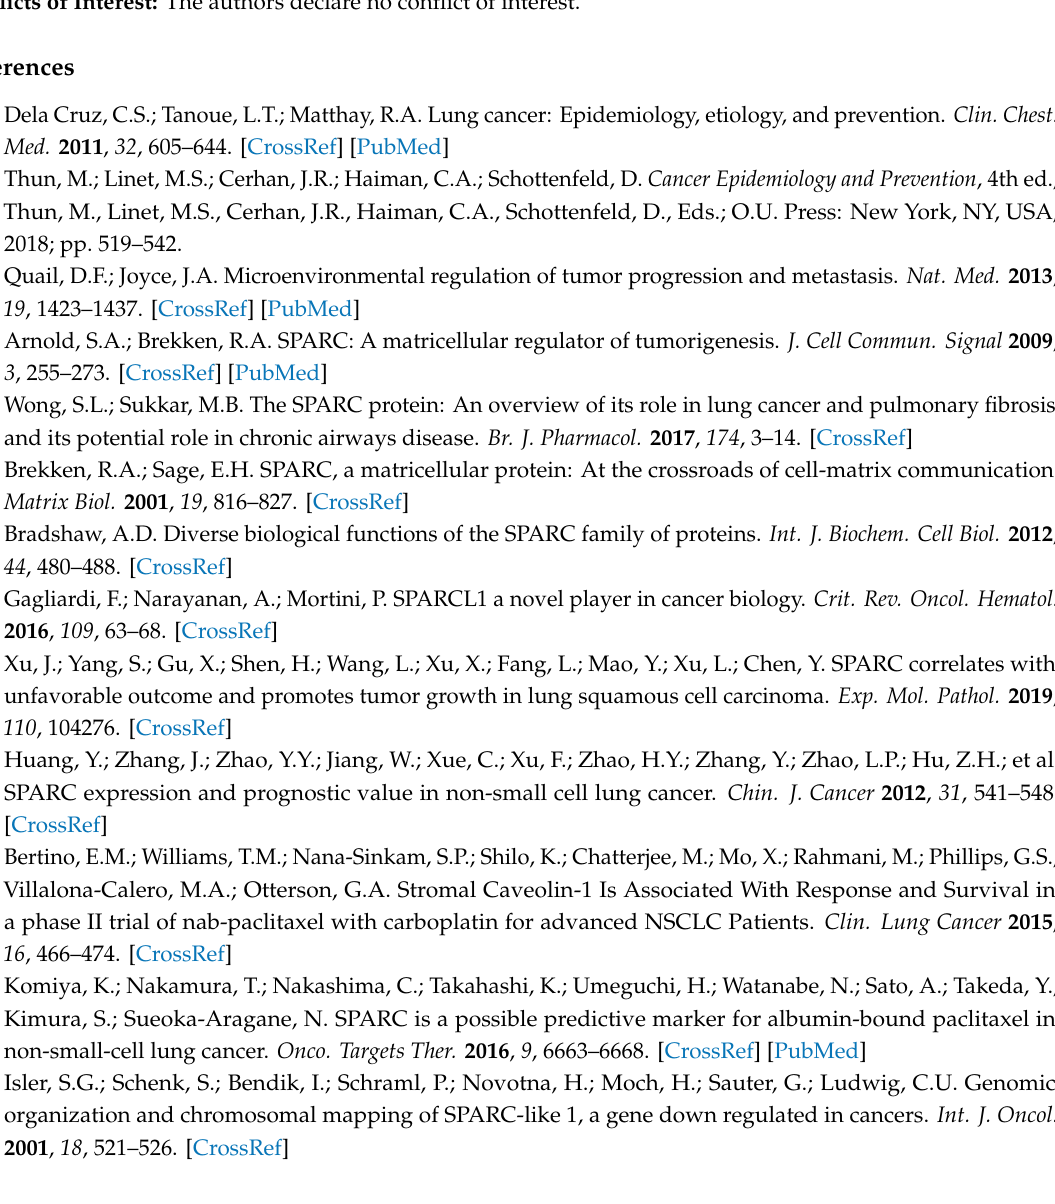
Figure S2: Correlation analysis between SPARC methylation and expression values from TCGA datasets; Figure S3: Variable dependence plots show the relationship between SPARC methylation levels and both the overall-survival and progression-free survival; Table S1: Molecular alterations in EGFR and KRAS genes identified by Sanger sequencing in NSCLC